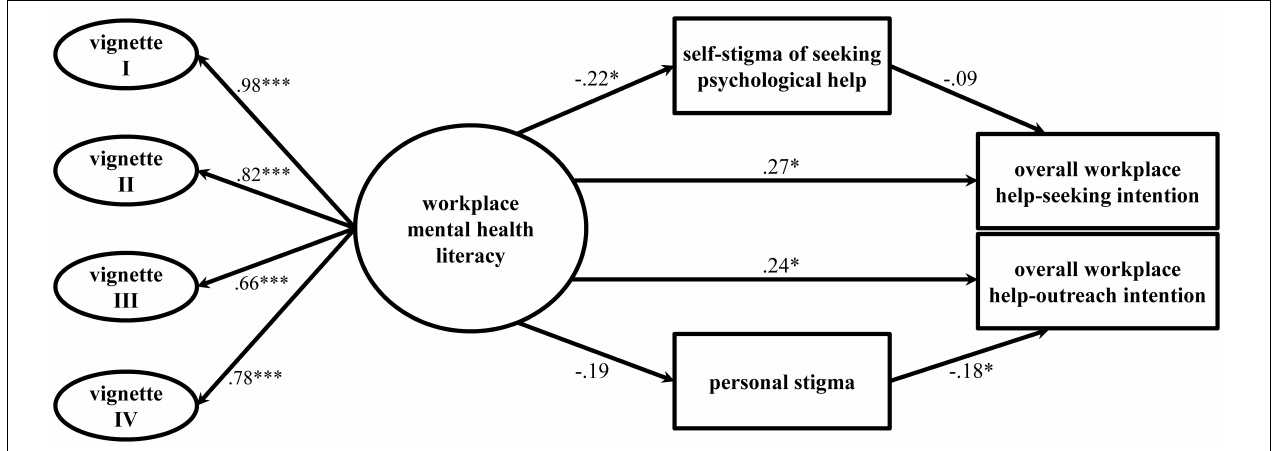
FIGURE 2 | Workplace mental health literacy as predictor of overall workplace help-seeking intention and help-outreach intention. n = 112, path model with standardized beta coefficients and without error terms. * p < 0.05; ** p < 0.01; *** p <